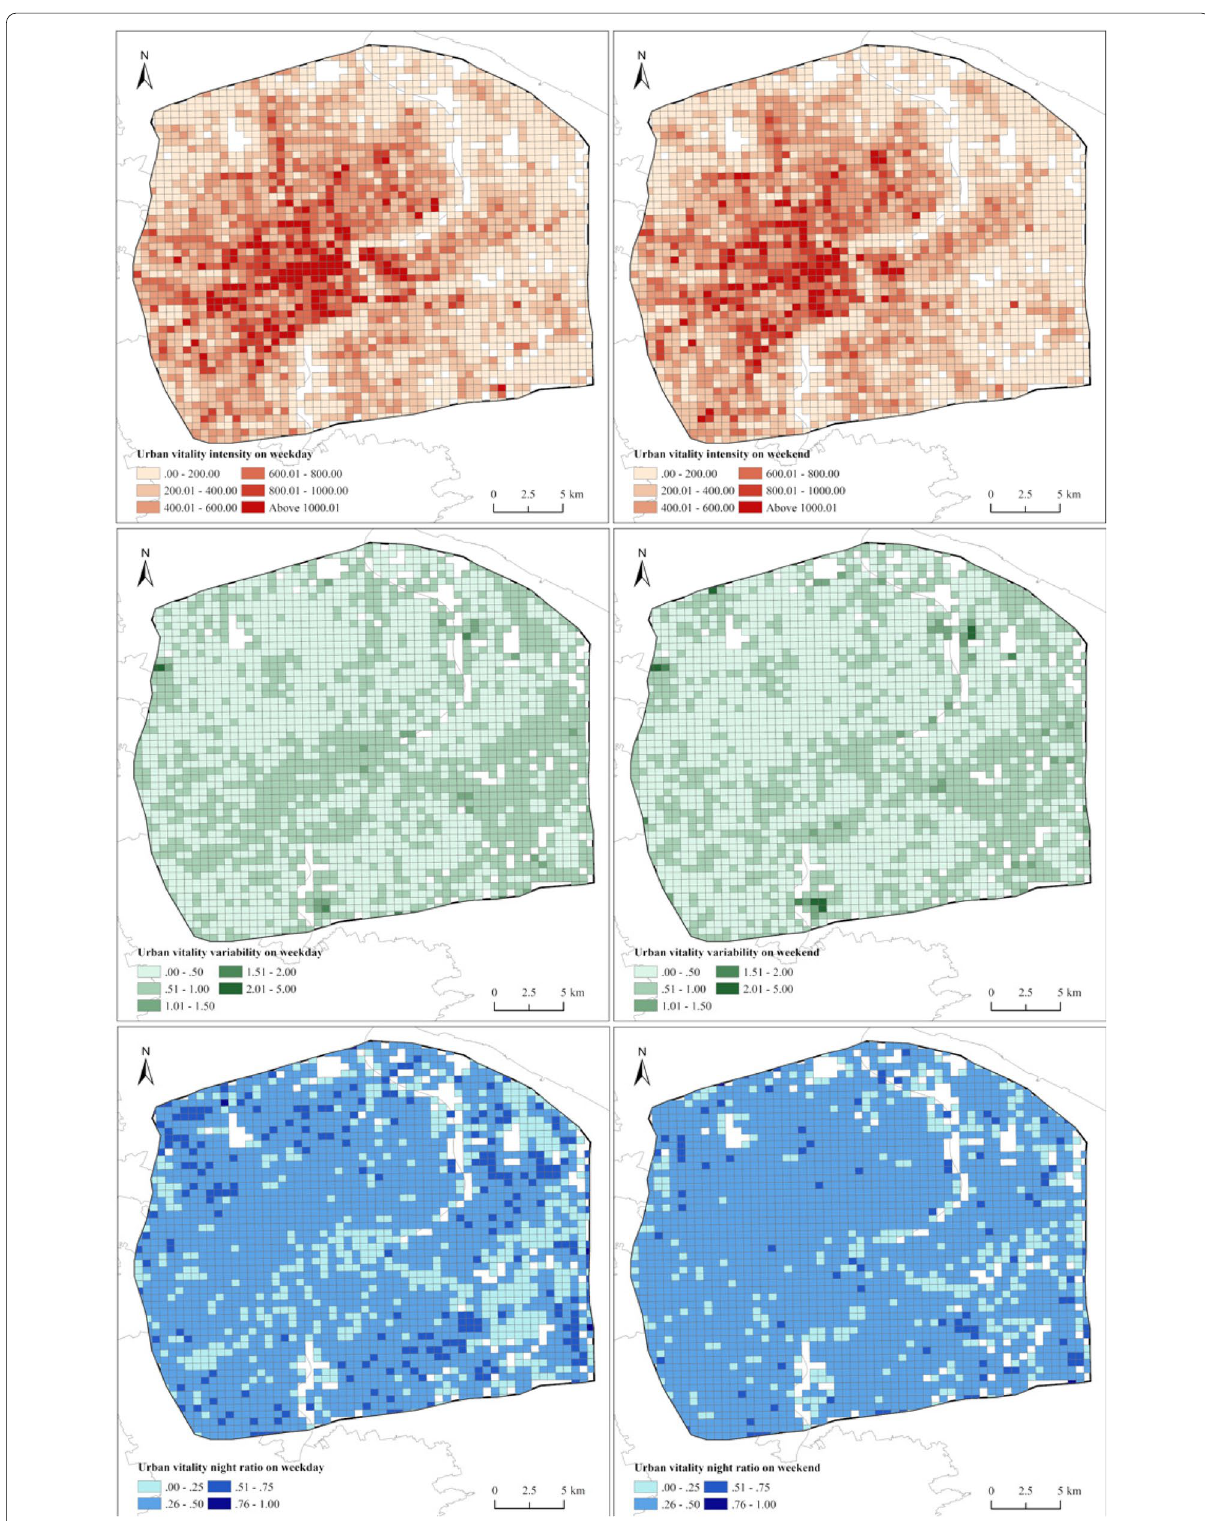
Fig. 4 Urban vitality on an average weekday and